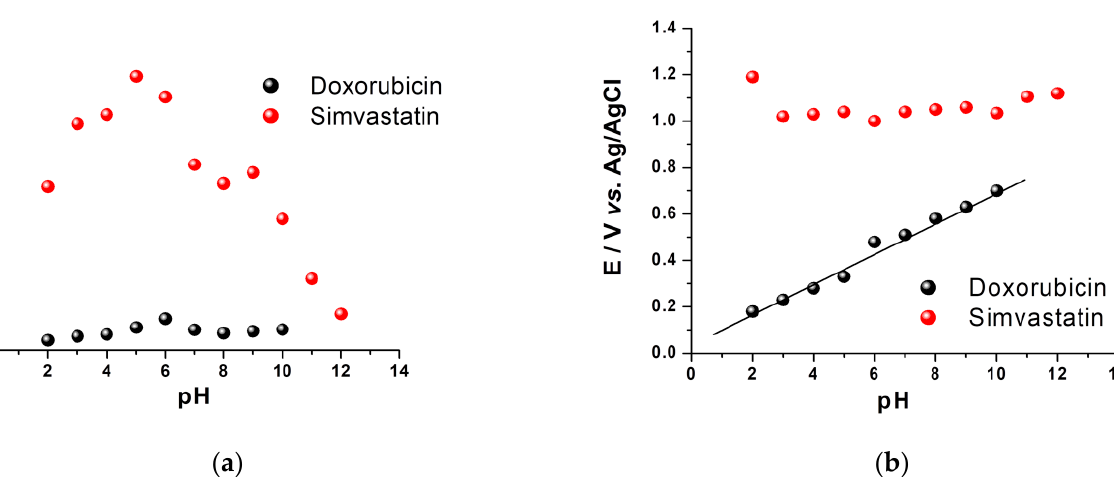
Figure 2. The influence of the pH on the intensity of the analytical signal ( a ) and oxidation potential ( b ) for 54.35 μg /mL (100 μM) DOX solution(black) and 1 mg/mL SMV solution (red), (scan rate: 100 mV/s, potential range: ( − 0.1, +0.8 V)/Ag for DOX and ( − 0.5, +1.6 V)/Ag for SMV.